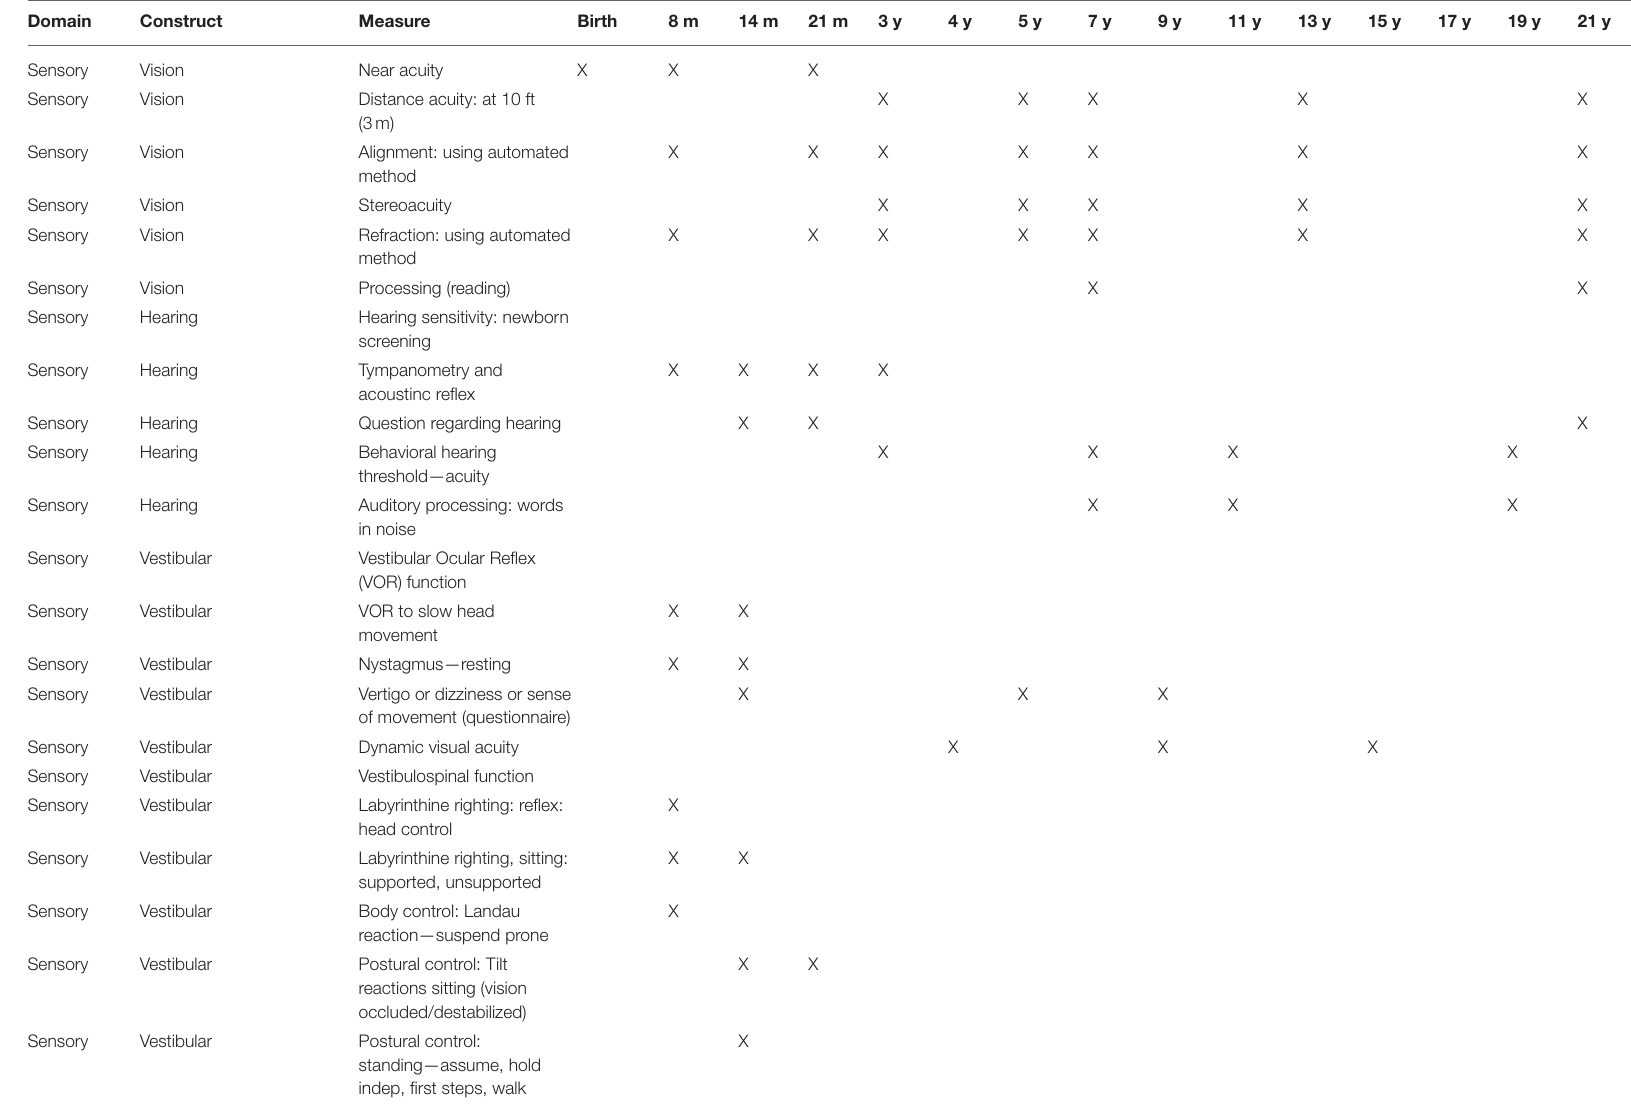
TABLE 2 | Recommended sensory